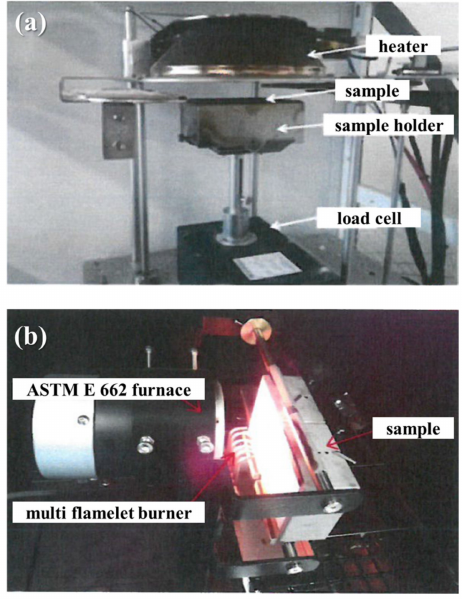
Figure 4. Photographs of ( a ) cone calorimeter and ( b ) smoke density tester.